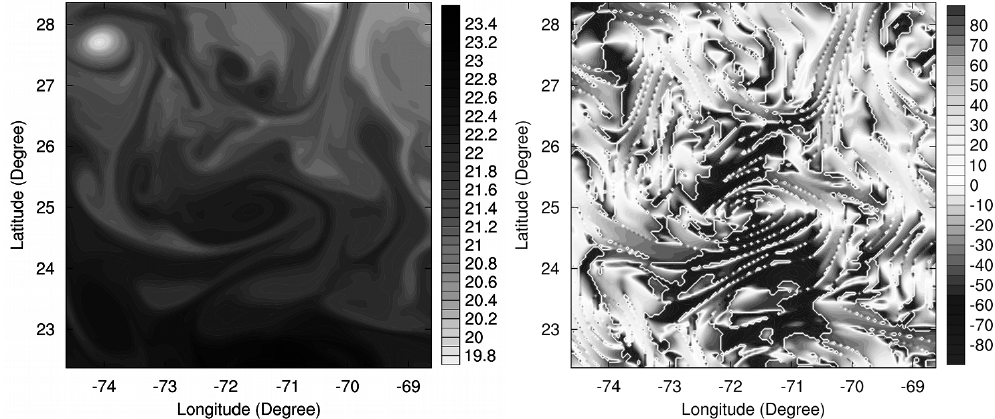
Figure 10. SST field (left panel) and the corresponding orientations (angular degree) of the gradients (right panel). The SST field comes from the same ocean simulation from which the BFTLEs (BFTLVs) were computed to produce fields in Fig. 9.